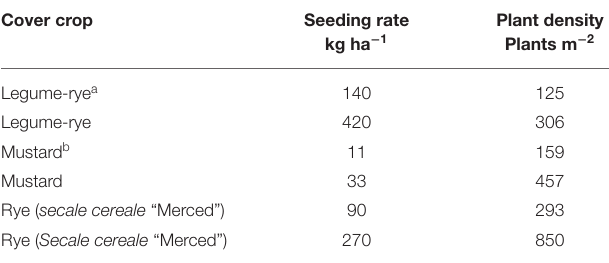
TABLE 1 | Cover crop seeding rates and resulting mean cover crop densities during two years in Salinas CA, USA. Cover crop